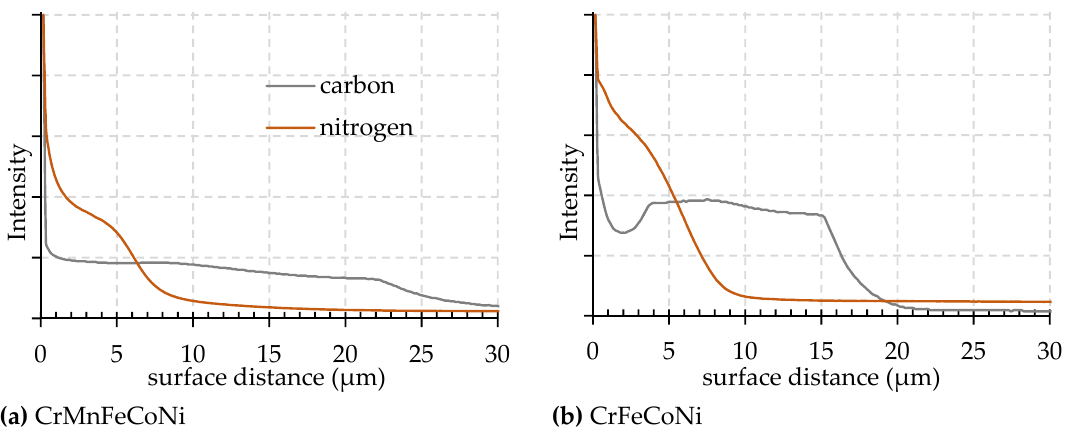
Figure 1. Depth profile measured by glow discharge optical emission spectroscopy (GDOS) measurement.